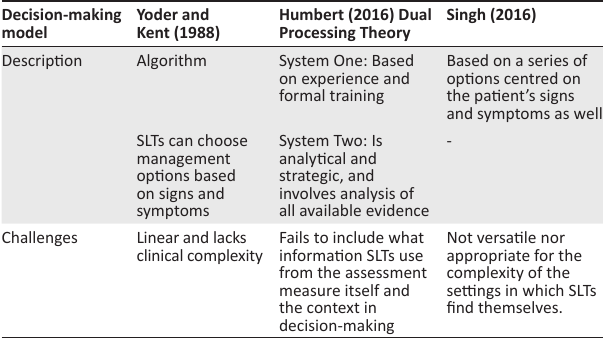
TABLE 1: Description of the decision-making models and the